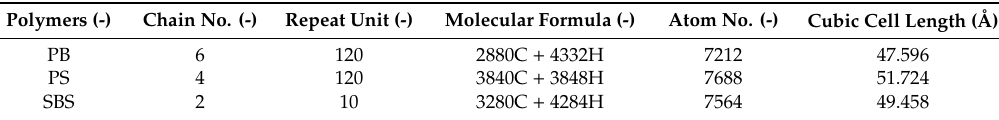
Figure 1. Detailed molecular structures and models of the three polymers. The schematic chemical structure for: ( a ) cis -1, 3-polybutadiene, PB; ( b ) polystyrene, PS; ( c ) styrene-butadiene-styrene block copolymer, SBS. The repeat units of molecular chain structures: ( d ) 1,3-butadiene, ( e ) styrene, ( f ) styrene-butadiene. Molecular chain configurations: ( g ) polybutadiene, ( h ) polystyrene, ( i ) styrene–butadiene–styrene block copolymer. The molecular configurations of the three di ff erent packing models: ( j ) PB, ( k ) PS, ( l ) SBS, respectively. Table 1. Details of the constructed initial